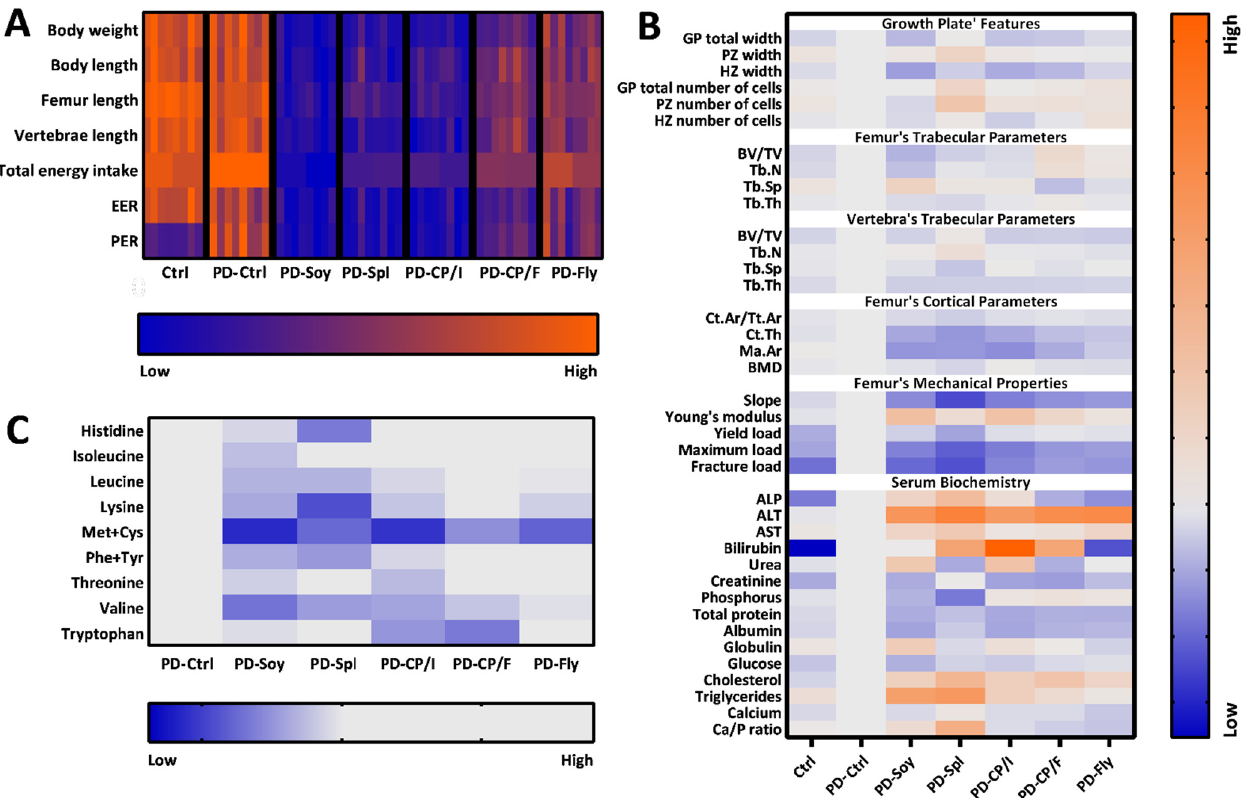
Figure 5. Evaluating protein quality through growth and eating patterns, bone features, serum parameters, and amino acid composition. ( A ) Heatmap representing the rats’ growth and eating performances. ( B ) Heatmap representing groups’ bone analyses’ results and serum biochemistry relative to PD-Ctrl’ values. ( C ) Heatmap representing protein sources’ amino acid content relative to PD-Ctrl’ AA profile.